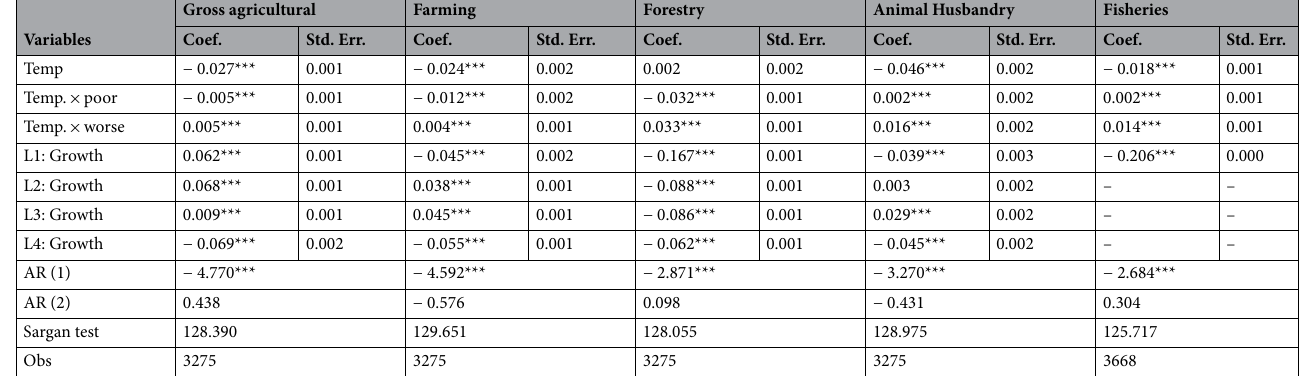
Table 5. Screening of variation in agricultural growth by temperature fluctuations. ***, **, * indicate significant at the statistical level of 1%, 5%, and 10%,